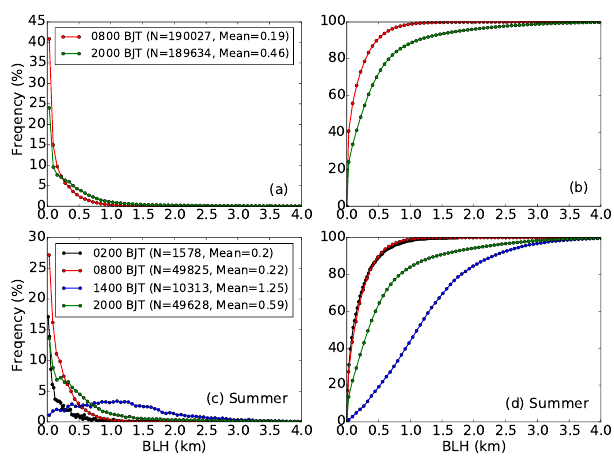
Figure 4. Frequency distribution (left) and cumulative frequency distribution (right) of CMA-BLH at 02:00 (in black), 08:00 (in red), 14:00 (in blue) and 20:00BJT (in green) during (a, b) the whole period and (c, d) the summertime from January 2011 to July 2015. The number of soundings ( N ) and mean value at each observed time are also given. Note that the soundings at 02:00 and 14:00BJT are occasionally launched during certain intensive observation periods in